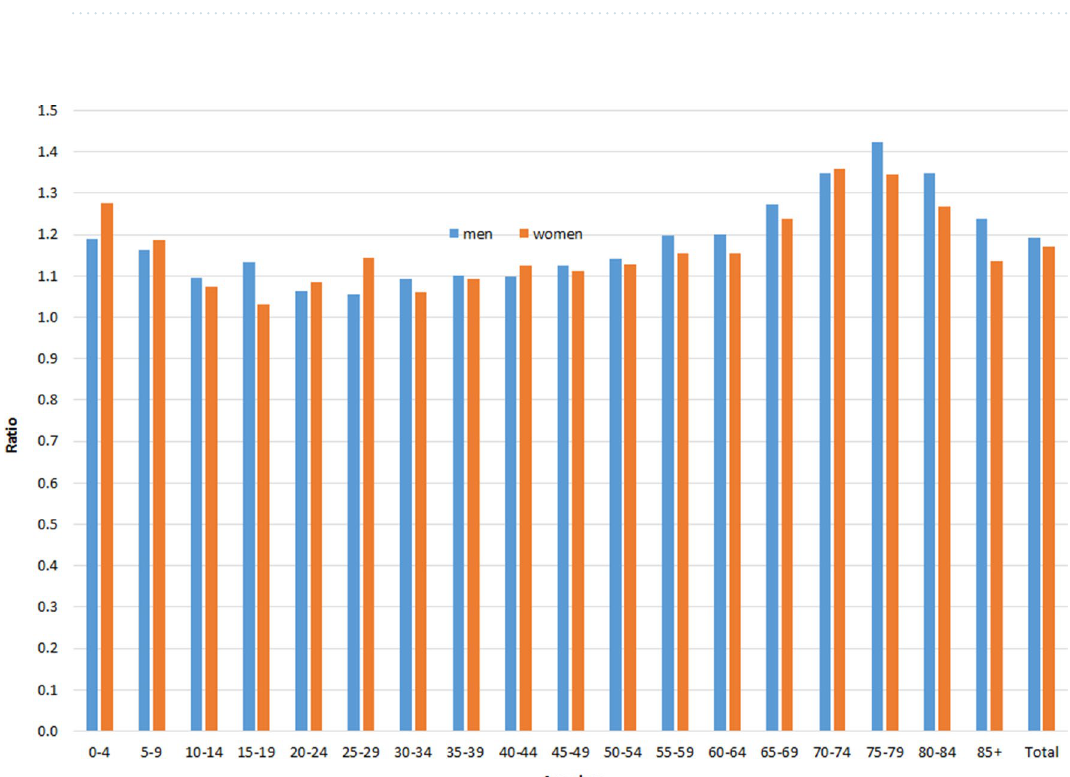
Figure 2. Age-specific mortality rates*10,000 person years among women resident in Italy, by citizenship and source of data. Istat, 2012–2016.